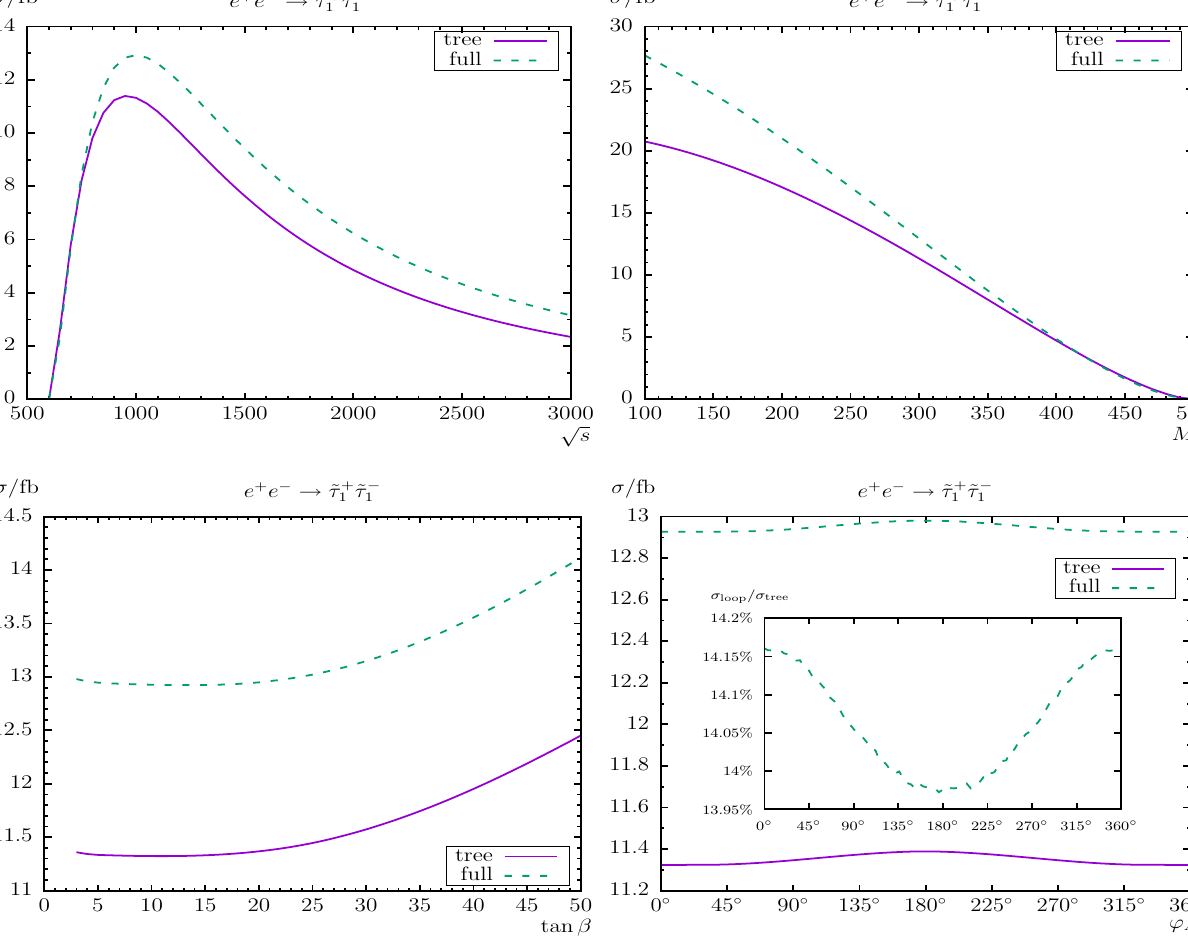
(right) varied. All masses and e g